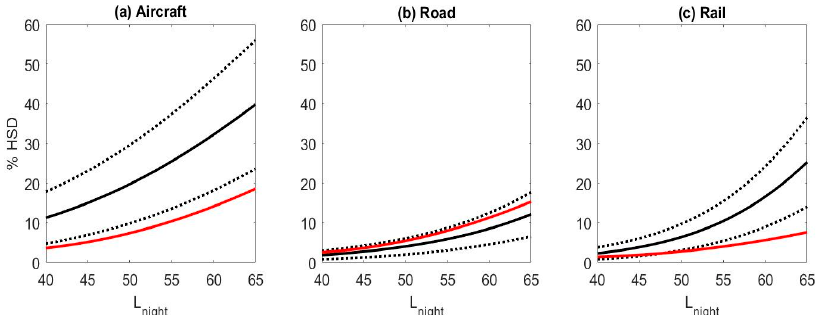
Figure 8. The percent highly sleep disturbed (HSD) based on responses to questions on awakenings, difficulty falling asleep, and sleep disturbance for road, rail, and aircraft noise (black dashed lines: 95% confidence intervals). The number of studies and subjects contributing to the analyses can be found in Tables 2–4. Red: Miedema and Vos (2007) [22] highly sleep disturbed exposure-response curves.